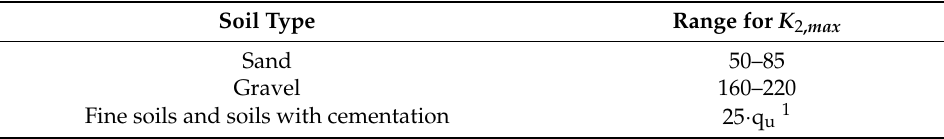
Table 2. Maximum shear coefficient for small deformations.